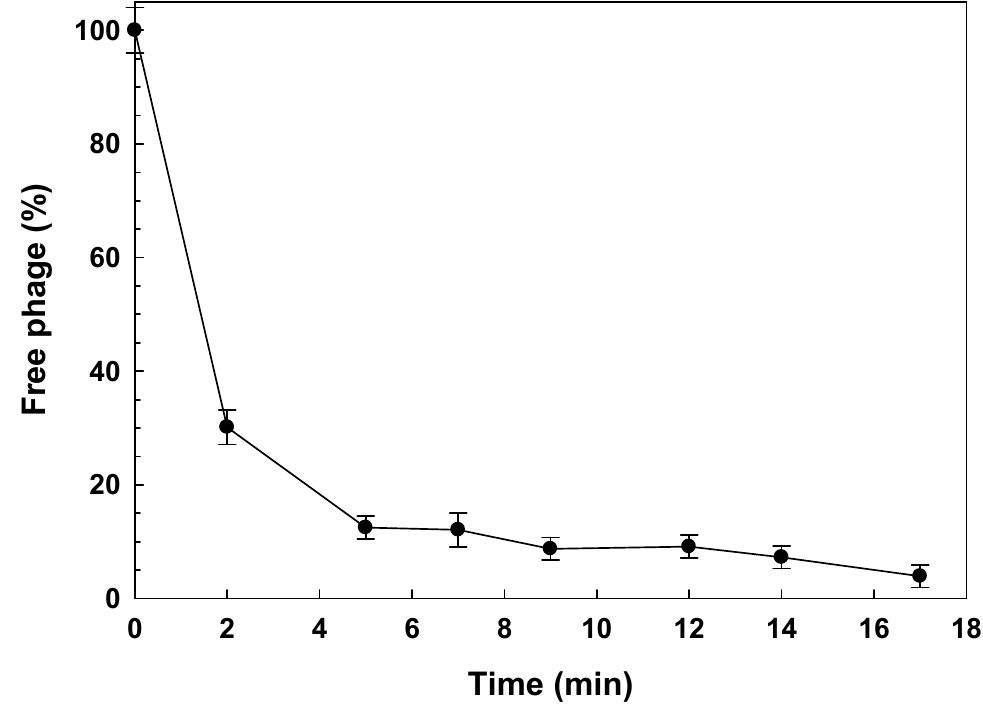
Figure 1. Phage Shi22 adsorption rate in TSB at 25 °C on ATCC12022 viable cells. A similar behavior was found for all the phages evaluated. Values are the mean ± standard deviation (error bars) of three determinations.